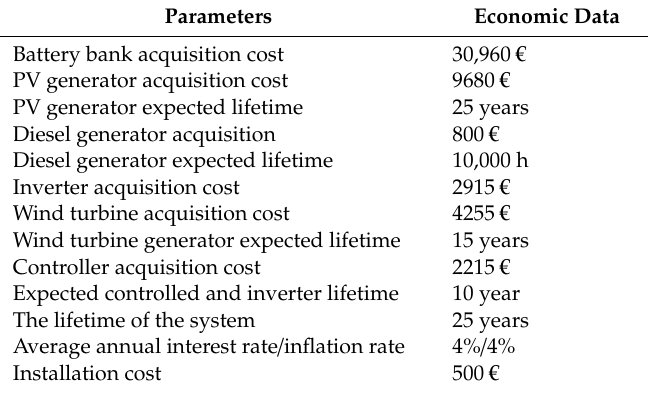
Table 4. Economic data for net present cost (NPC)